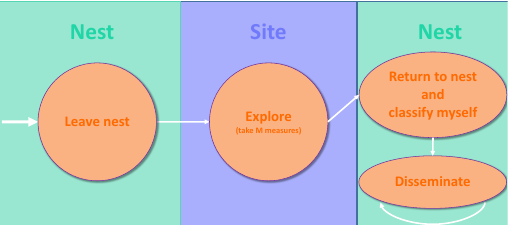
Figure 2. The extended robot’s behavioral model described as a finite state